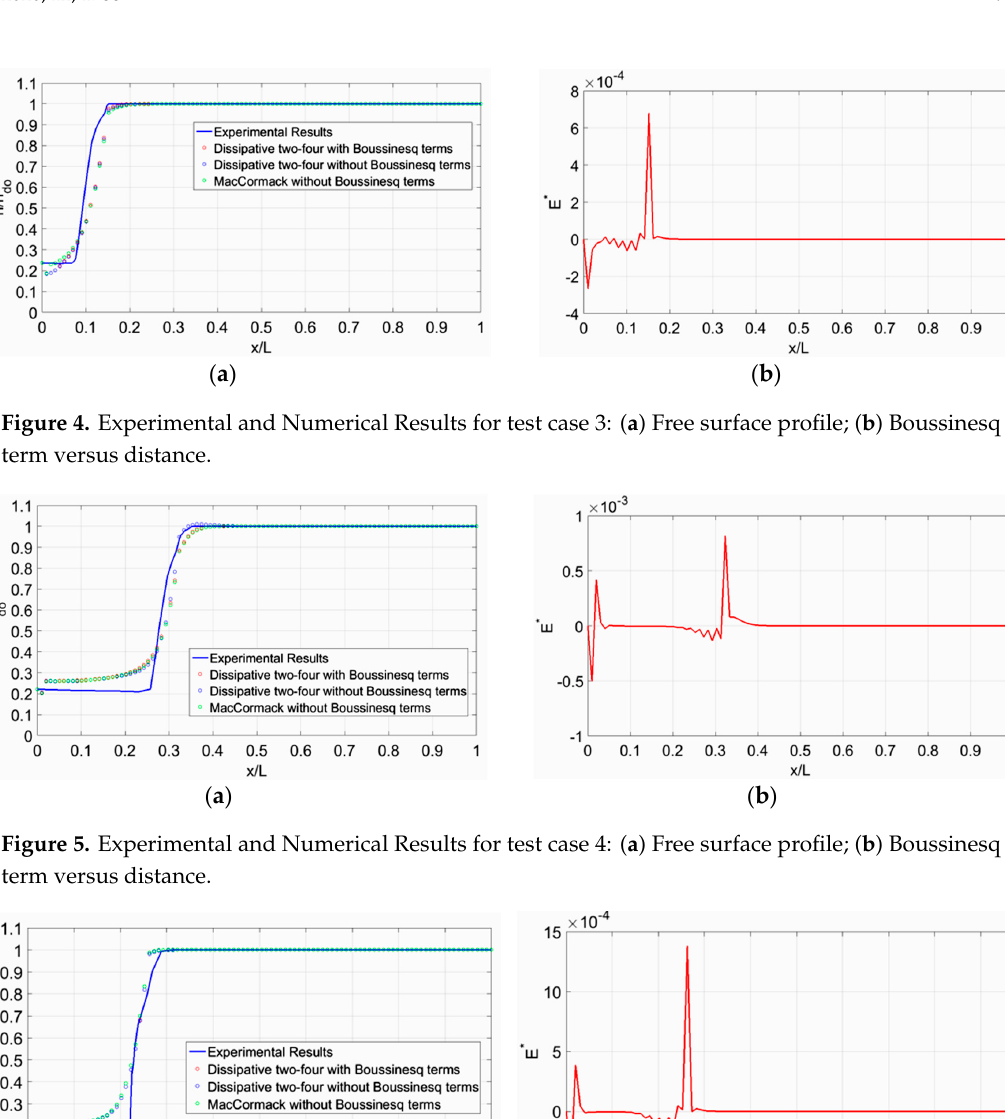
Figure 3. Experimental and Numerical Results for test case 2: ( a ) Free surface profile; ( b ) Boussinesq